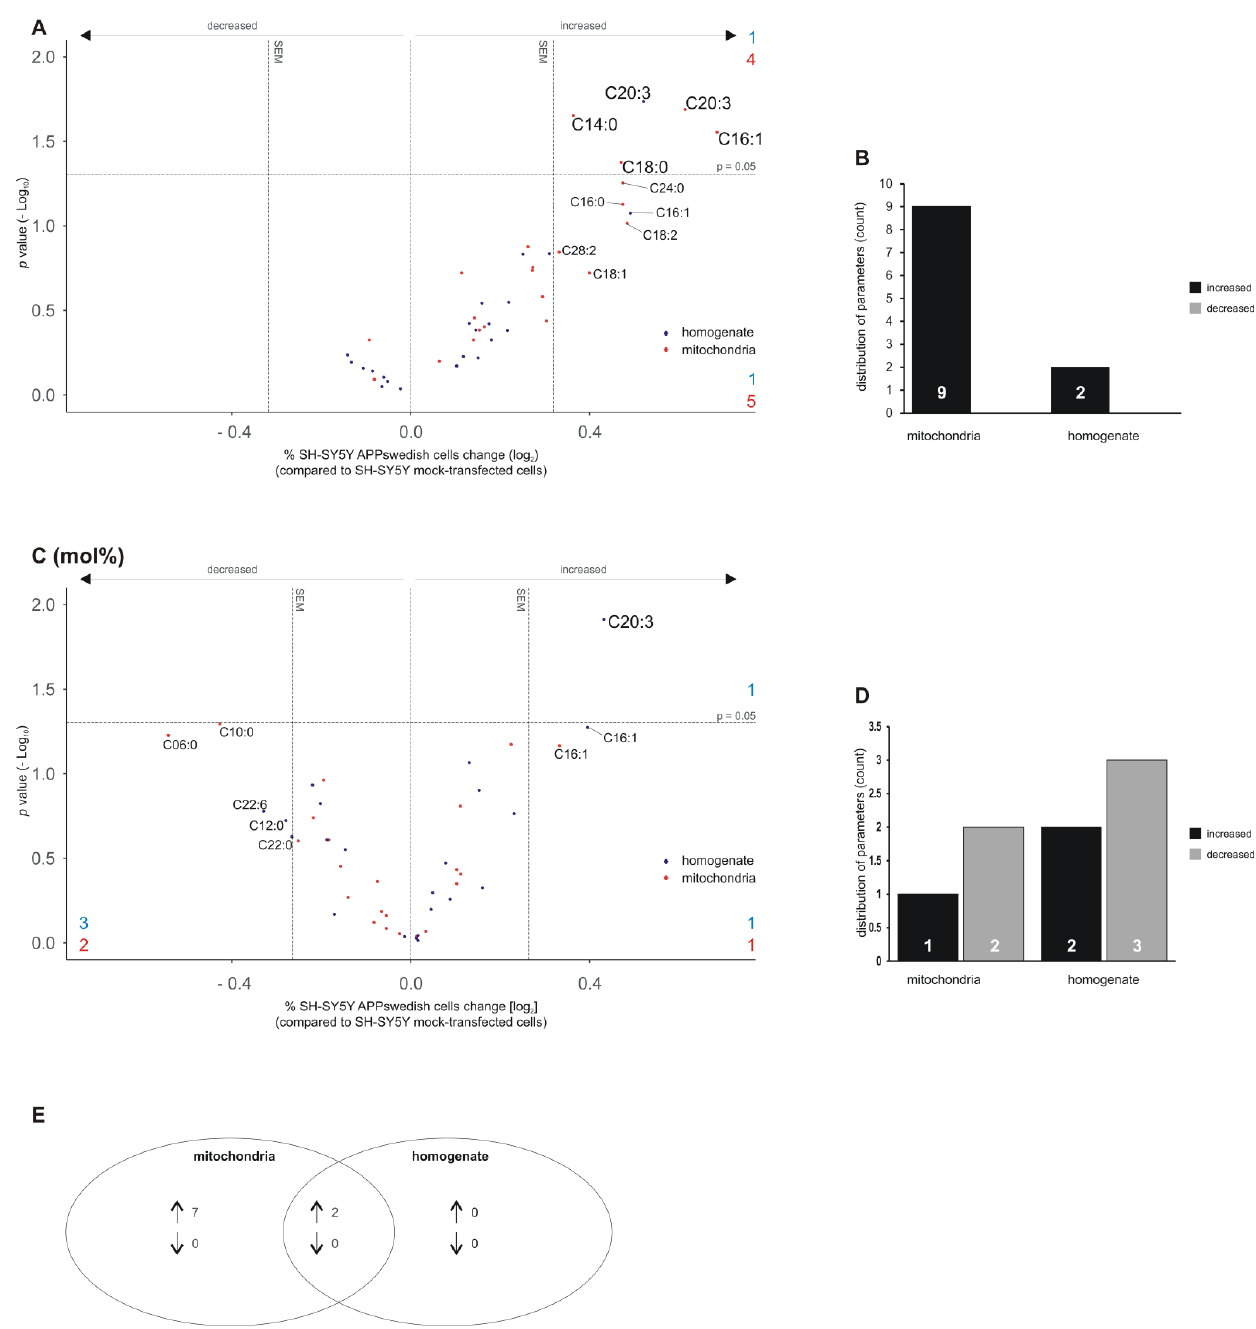
Figure 5. Changed lyso-phosphatidylcholine (lyso-PC) levels in homogenates and mitochondria of SH-SY5Y APPswedish cells in comparison to mock-transfected SH-SY5Y cells, respectively. ( A , B ) The fold changes of single lyso-PC species in homogenates and mitochondria are shown as volcano plots and the corresponding distribution analysis is shown in a bar chart on the right. ( C , D ) The effects of single lyso-PC species independent of lyso-PC lipid class effect are presented as appropriate volcano plot and bar chart. Vertical dashed lines next to 0.0 represent the average SEM and the horizontal dashed line marks p = 0.05 in volcano plots. Statistical significance was calculated using Fisher’s exact test. ( E ) Venn dia- gram showing the number of exclusively changed as well as overlapping lyso-PC species in mitochondria and homoge- nates in SH-SY5Y APPswedish cells compared to mock-transfected cells. Arrows indicate decreasing ( ↓ ) or increasing ( ↑ ) effects.